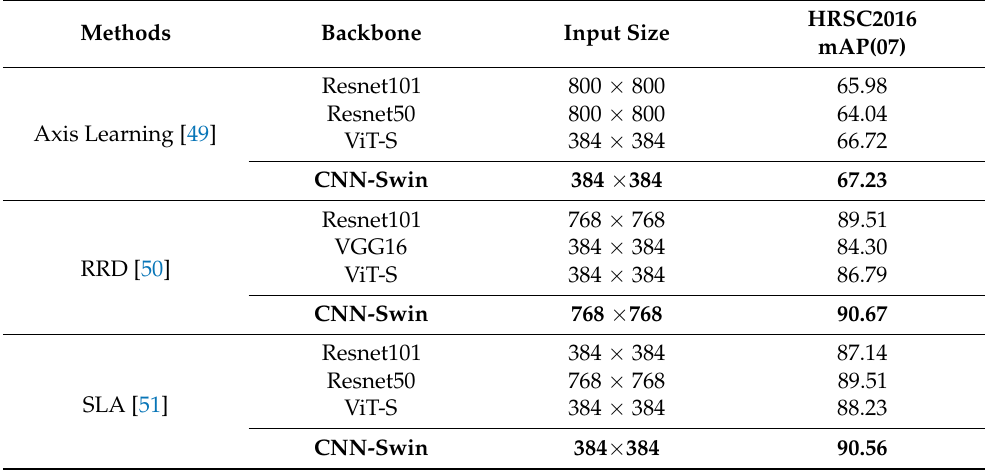
Figure 6. Confusion matrices of state-of-the-art approaches for military ship dataset: ( a ) Densenet-121, ( b ) Efficientnet, ( c ) Resnet-18, ( d ) Regnet, ( e ) ViT-base, ( f ) CaiT, ( g ) Swin-base, and ( h ) CNN-Swin. Table 4. Performance comparison of different methods with different backbones for ship detection in the HRSC2016